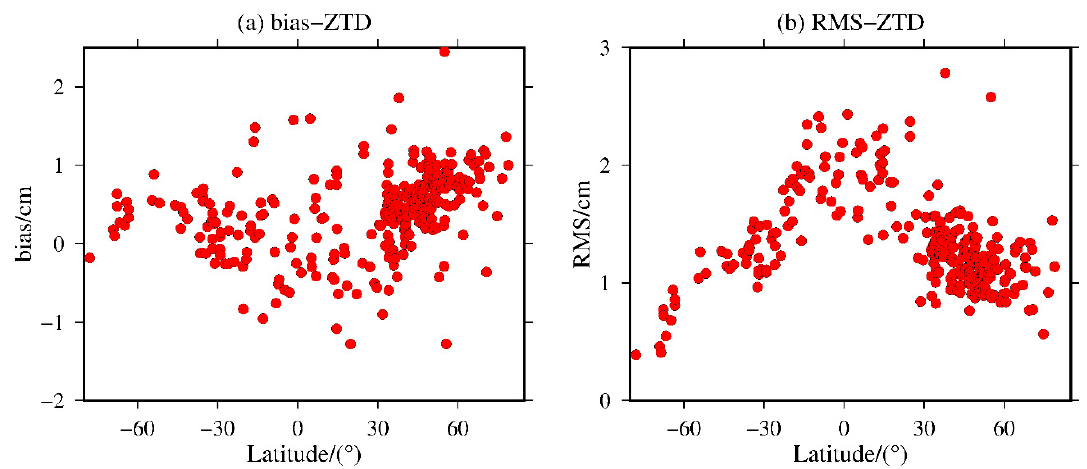
Figure 8. The ( a ) bias and ( b ) RMS of the MERRA-2 ZTD values with respect to latitude variations.